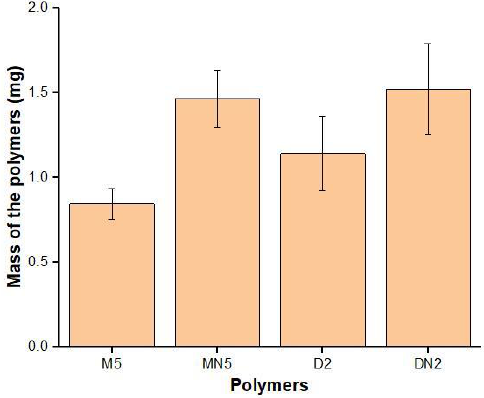
Figure 3. Swelling performance of the polymers.